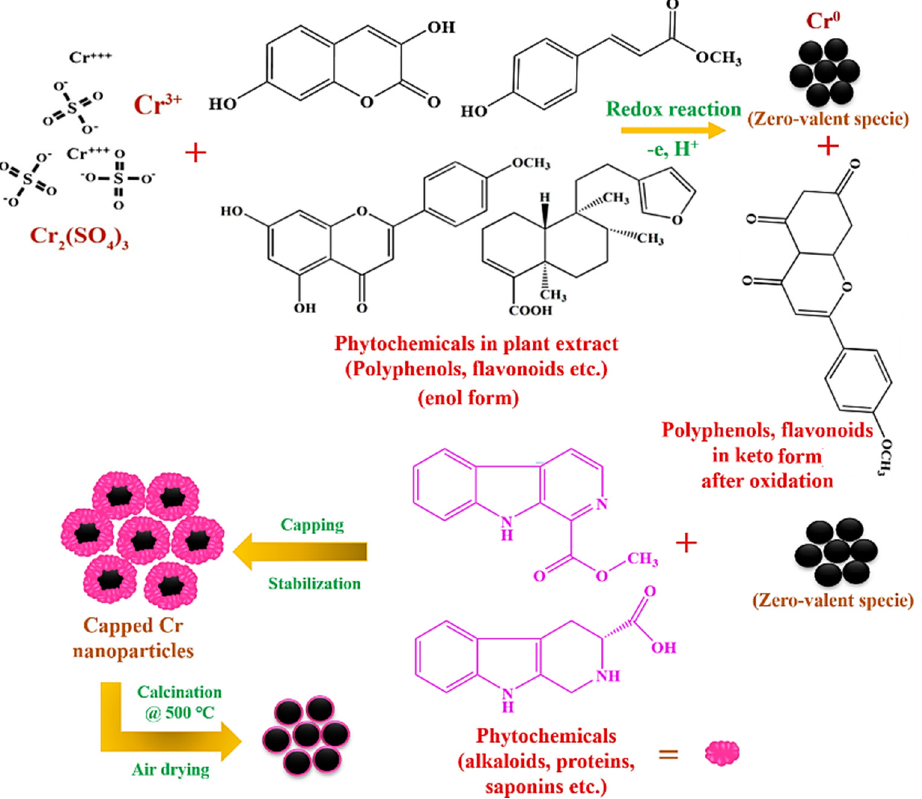
Figure 1. The schematic presentation for the green synthesis of Cr 2 O 3 nanoparticles using Abutilon indicum (L.) Sweet leaf extract. Abutilon indicum (L.) Sweet leaf